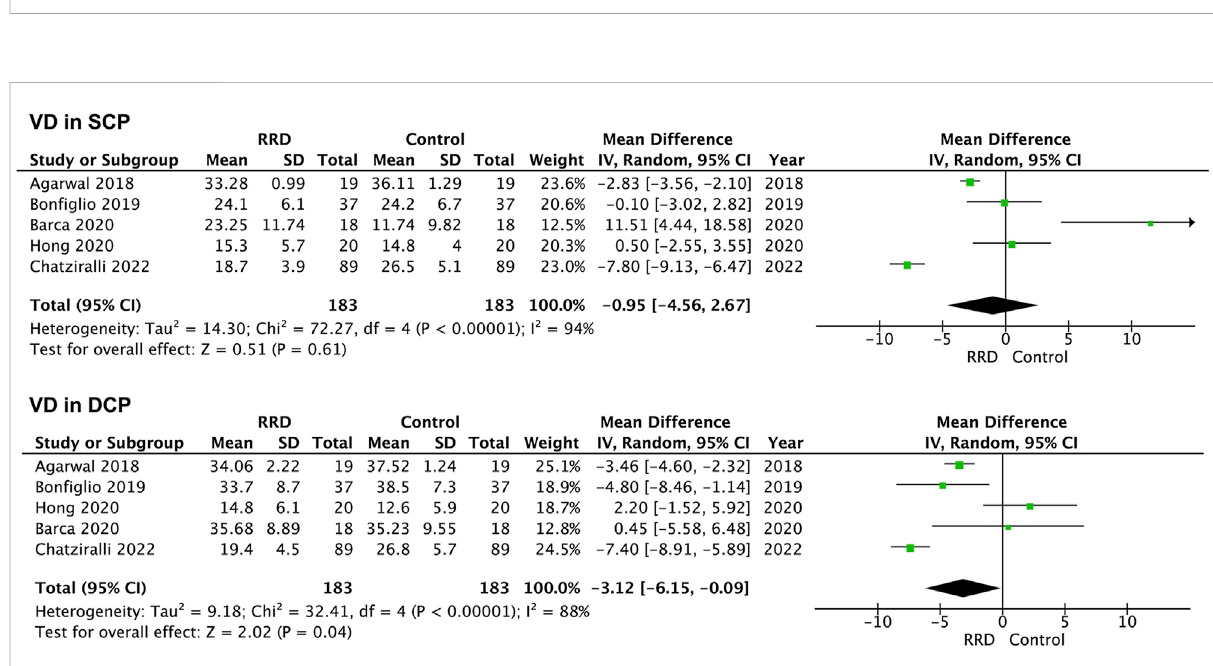
FIGURE 5 Forest plots of changes in foveal VD in eyes with Macula-off RRD. VD, vascular density, SCP, super fi cial capillary plexus; DCP, deep capillary plexus, RRD, rhegmatogenous retinal